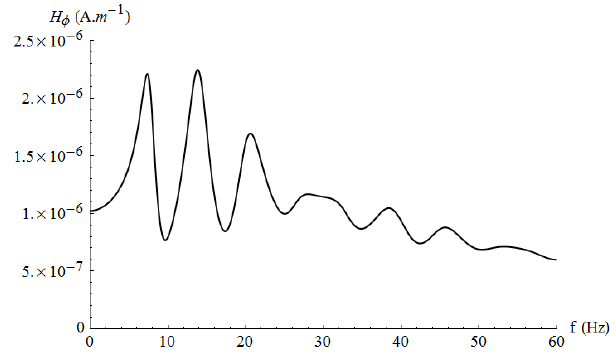
Figure 15: Magnetic field versus frequency at a distance of 5000 km from the